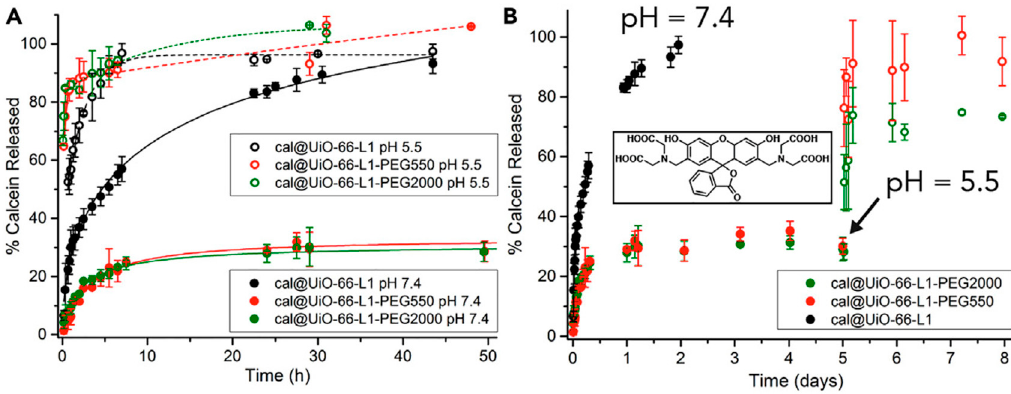
Figure 6. pH-responsive release of calcein from PEGylated UiO-66. ( A ) Calcein-release profiles from UiO-66-L1, UiO-66-L1-PEG550, and UiO-66-L1-PEG2000 in PBS (pH 7.4 and 5.5). ( B ) pH-responsive release of calcein from the PEGylated MOFs. Inset: chemical structure of calcein. Error bars denote standard deviations from triplicate experiments [67].